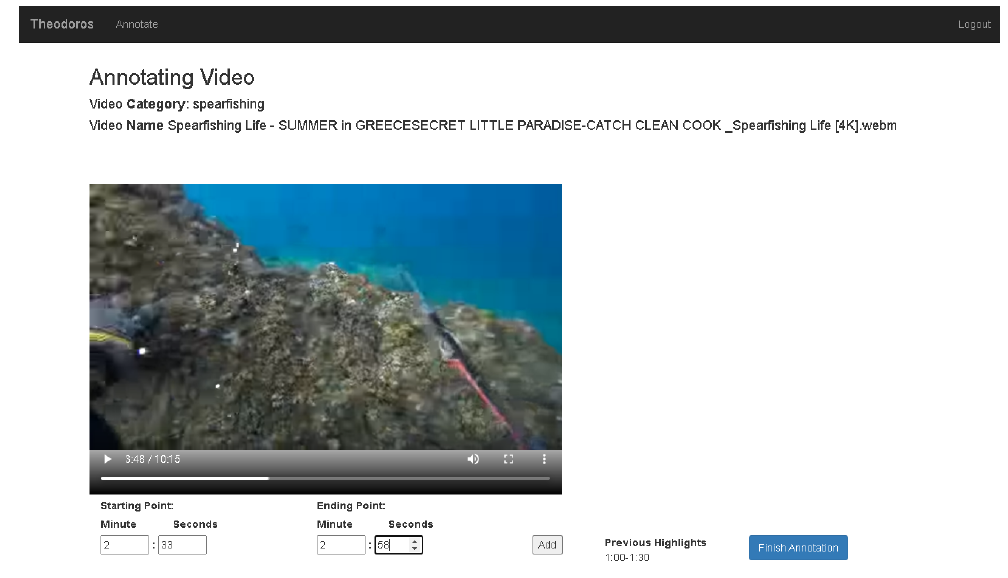
Figure 3. The annotating page of the web application.